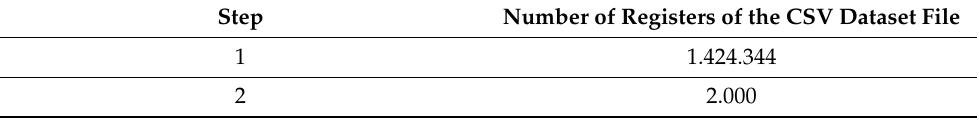
Table 6. Dataset obtained in each step and the number of